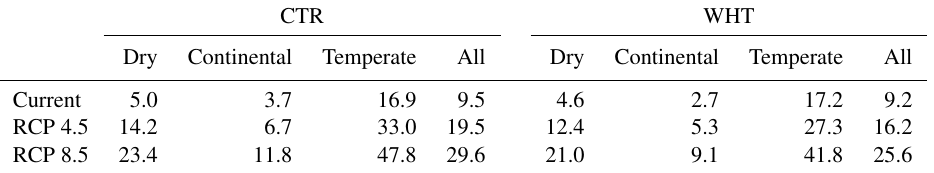
Table 2. The mean anthropogenic heat flux for all the selected cities and the cities in the three climate zones in the current climate, RCP 4.5, and RCP 8.5 scenarios from both the control (CTR) and the white roof (WHT) simulations. (Units: Wm − 2 ) Daytime CTR WHT Dry Continental Temperate All Dry Continental Temperate All Current 8.9 2.3